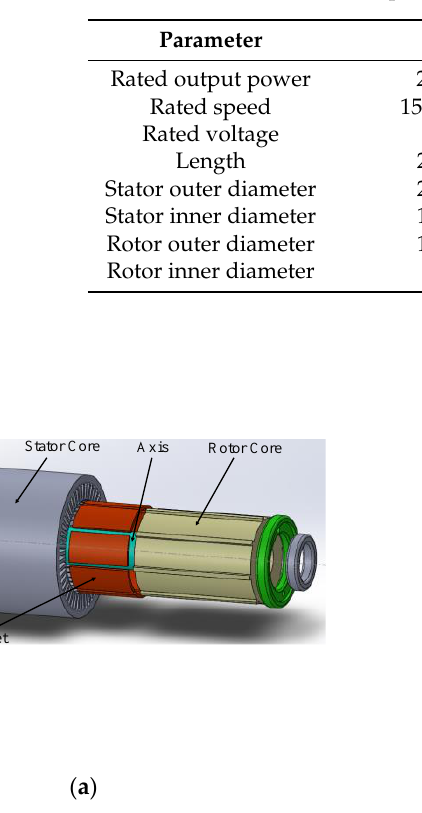
Table 1. Parameters of the adopted motor.